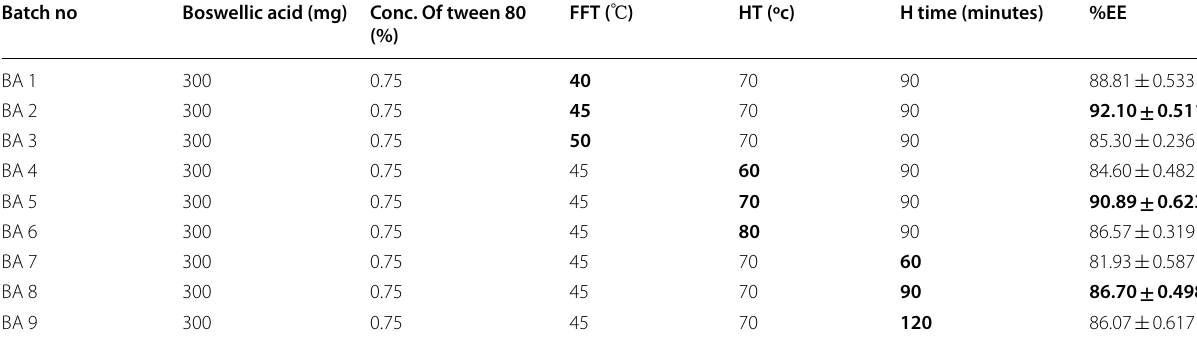
The bold digit in column 4, 5 and 6 differentiate the condition while bold digit in last column indicate based on that result process parameters were selected (Mean SD, where n 3) ± =